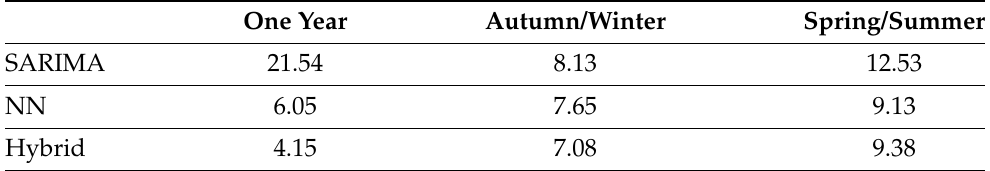
Table 8. A comparison between